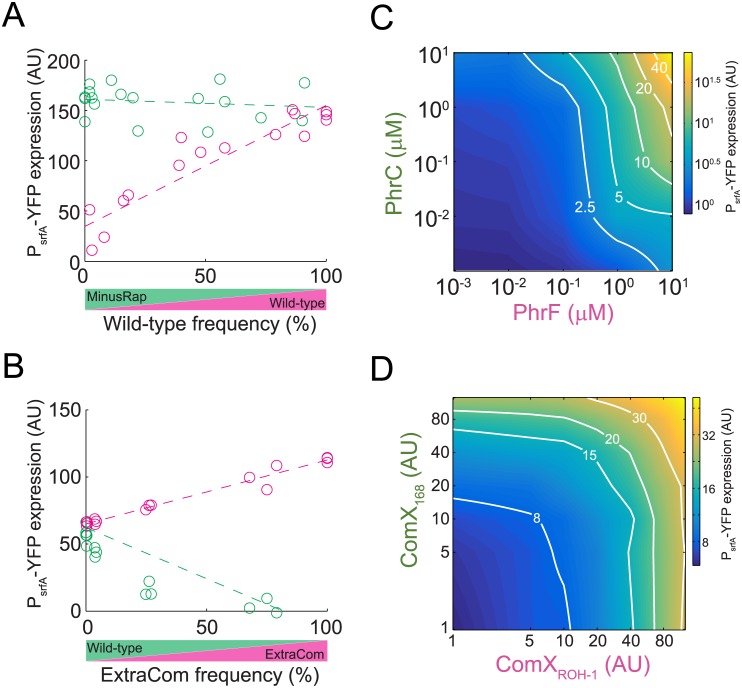
Experimental validation of predicted investment in cooperative behavior in coculture and the resulting regulatory gate of the wild-type.(A,B) Quorum-sensing response of each strain in cocultures of the wild-type (magenta) and the MinusRap (green) (A) and the wild-type (green) and ExtraCom (magenta) (B) strains. The quorum-sensing responses were measured by the fluorescence level of individual cells in which a PsrfA-YFP reporter was incorporated into the genome of one of the strains (see methods for details). Each circle represents a different experiment. Multiple experiments were repeated on multiple days. (C) The quorum-sensing response gate was measured using the PsrfA-YFP reporter in a strain deleted for phrC and phrF and constitutively expressing RapC and RapF. The response was measured at a constant OD for different concentrations of externally added PhrC and PhrF autoinducers. (D) The quorum-sensing response was measured using the PsrfA-YFP reporter for the ExtraCom strain. Varying levels of conditioned medium prepared from strains harboring only one of the ComP-ComX systems were supplied to a low-cell density population of ExtraCom cells. Shown in both (C,D) is a heat map of a continuous interpolation of the data (original data are shown in S6A and S6C Fig and S1 Data). The equal-response lines are marked in white and indicated by their fold-response values.